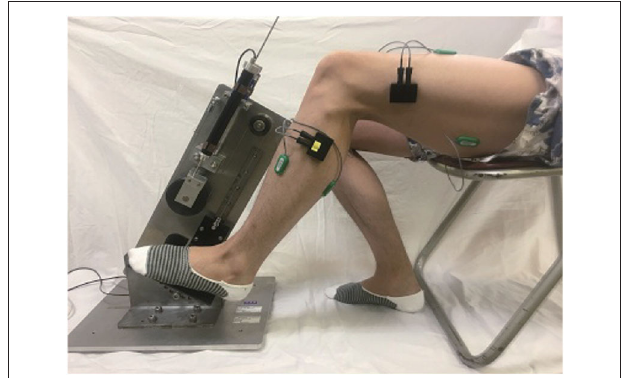
FIGURE 1 | A shot of pedaling